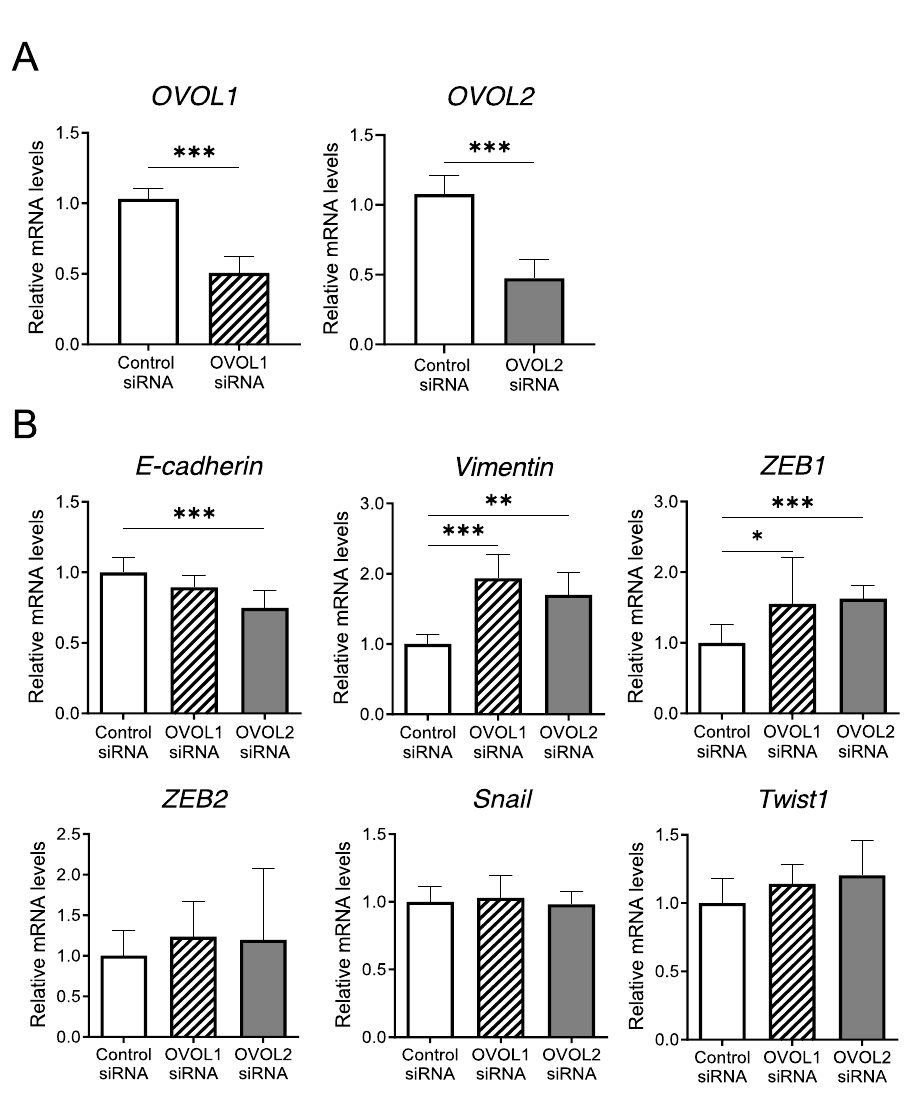
Figure 3. Vimentin and ZEB1 mRNA levels are regulated by OVOL1 / 2 knockdown in a human SCC cell line. ( A ) Relative mRNA levels of OVOL1 and OVOL2 in A431 cells treated with control siRNA, OVOL1 siRNA, or OVOL2 siRNA for 48 h. ( B ) Relative mRNA levels of E-cadherin , vimentin , ZEB1 , ZEB2 , Snail , and Twist1 in A431 cells treated with control siRNA, OVOL1 siRNA, or OVOL2 siRNA for 48 h. Mann–Whitney U -test; error bars represent mean ± standard deviation. For interpretation purposes, the control siRNA value was set to 1. p -values < 0.05 were assumed to indicate a statistically significant di ff erence; * p < 0.05, ** p < 0.01, and *** p < 0.001. Assays were conducted in triplicate and repeated at least three times in separate experiments.